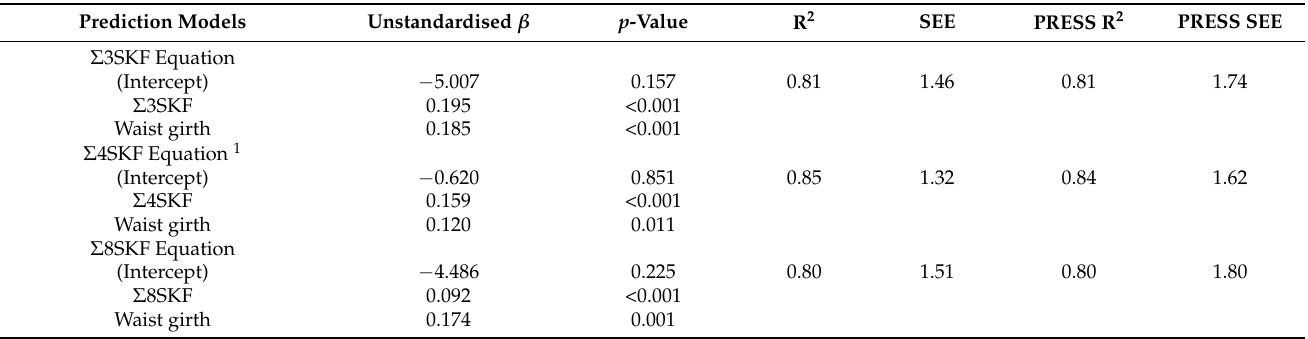
Table 4. Proposed fat mass percentage prediction equations for high-level male futsal players and PRESS cross-validation results ( n =